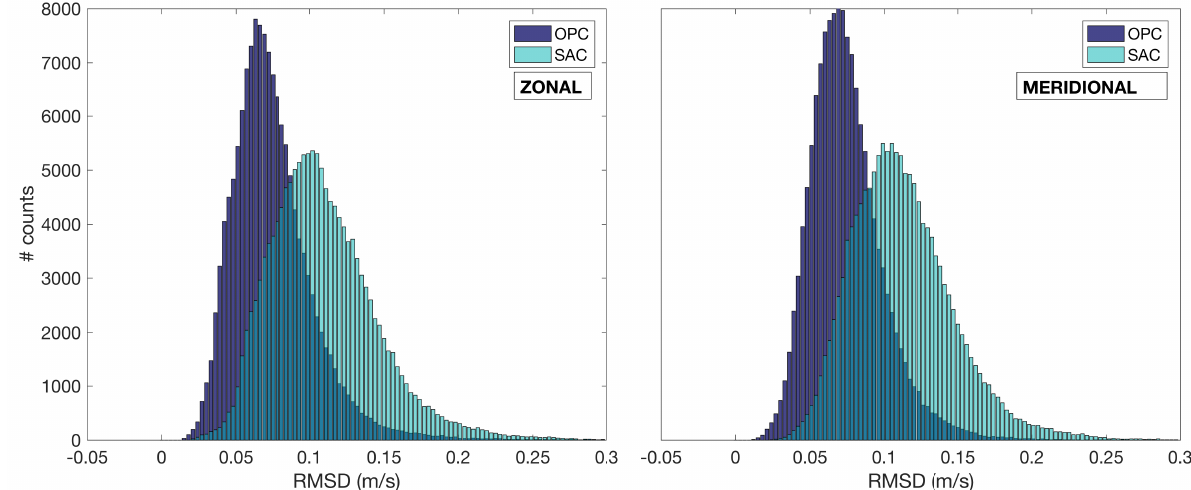
Figure 7. Distributions of the RMSD values for the SAC (light green) and OPC (blue). Left and right panels show the results for the zonal and meridional currents,